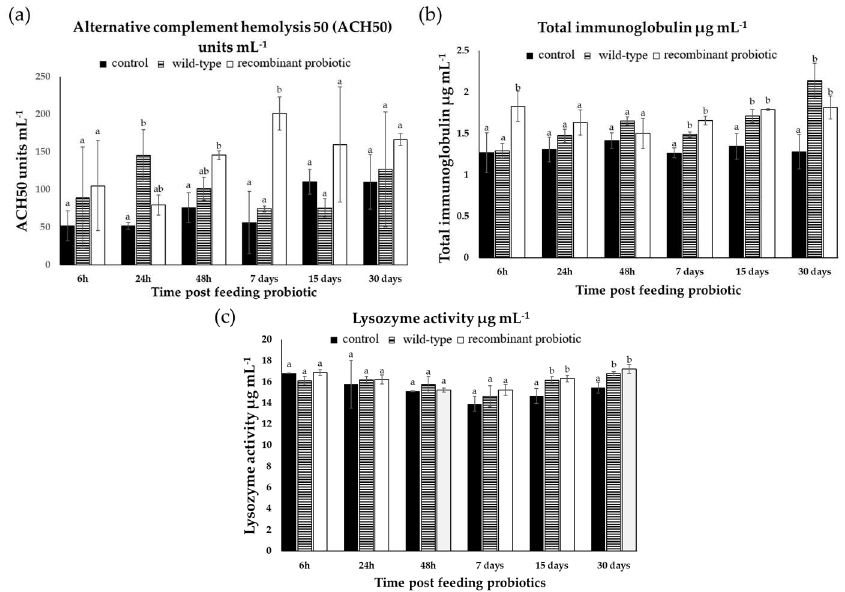
Figure 7. Immune parameters of Nile tilapia fed experimental diets. ( a ) Alternative complement hemolysis 50 (ACH50); ( b ) total immunoglobulin; ( c ) lysozyme activity of Nile tilapia fed with experimental diets for 30 days (n = 5). Bars with different letters indicate significant differences ( p <